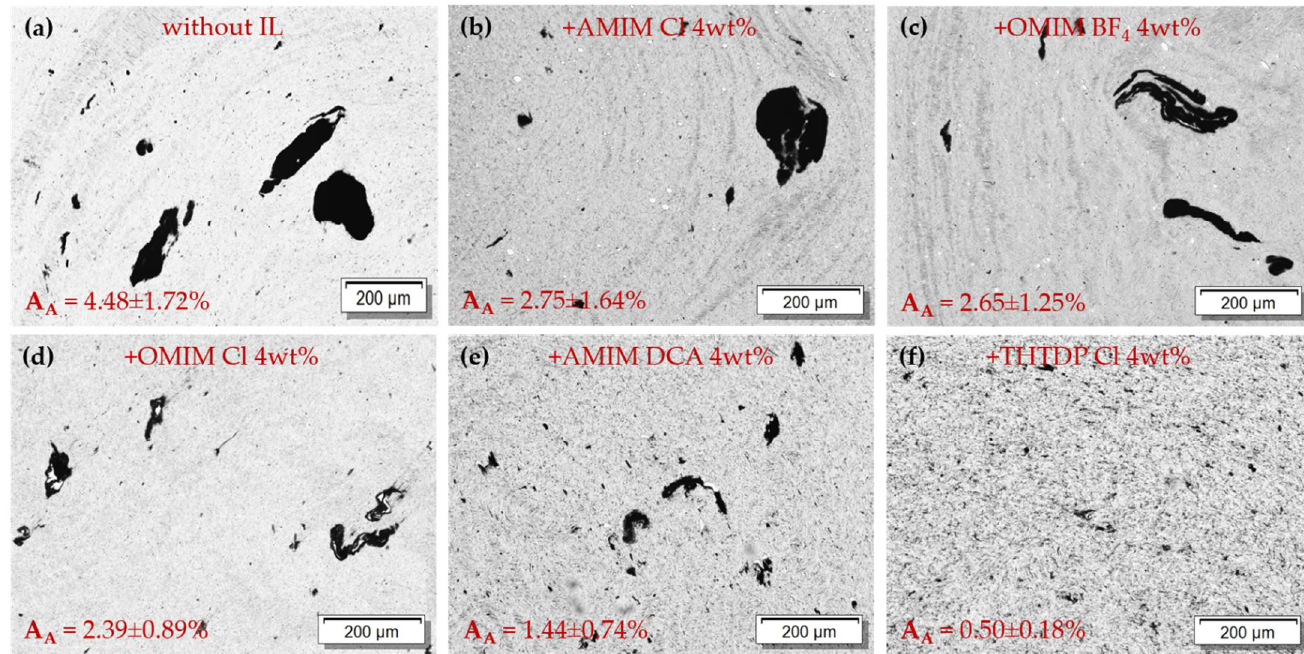
Figure 3. Light microscopy images and agglomerate area ratios of different composites: ( a ) PP/1 wt.% SWCNT, ( b ) PP/1 wt.% SWCNT + 1 wt.% AMIM Cl and ( c ) PP/1 wt.% SWCNT + 2 wt.% AMIM Cl.